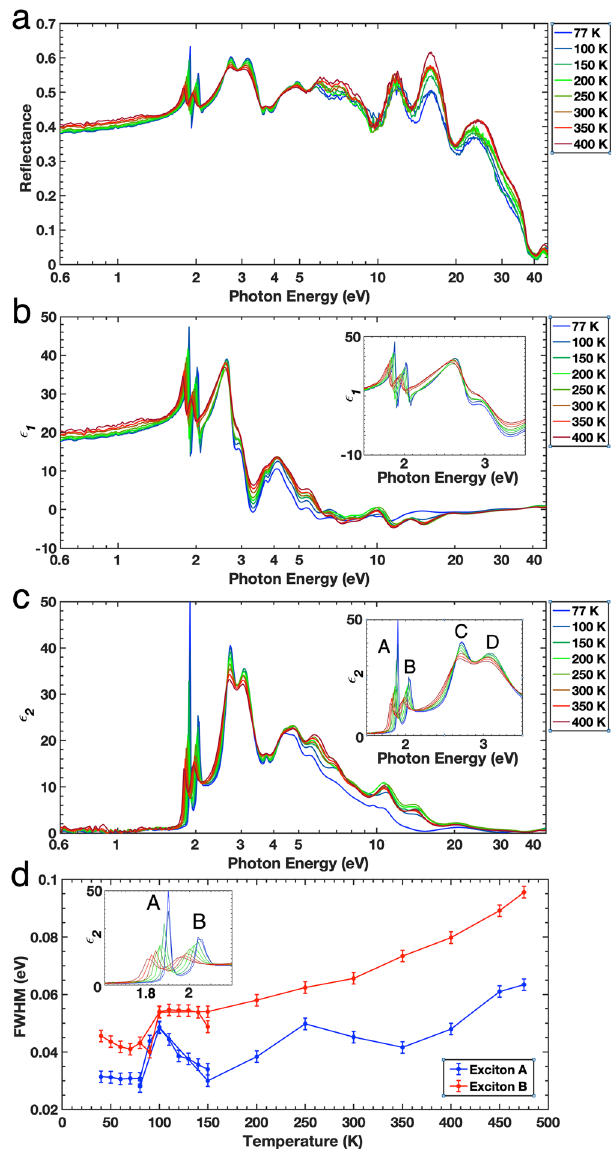
Fig. 1 Re fl ectance measurements and complex dielectric function of MoS 2 as a function of temperature. a Measurements of the re fl ectance of the bulk MoS 2 from the near-infrared (0.6 eV) up to soft X-ray (45 eV) using the SUV beamline at SSLS, log scale. The b real ( ε 1 ) part and c imaginary ( ε 2 ) part of the complex dielectric function of MoS 2 from spectroscopic ellipsometry and soft X-ray re fl ectance, log scale. d The FWHM of excitons A and B as a function of temperature showing signi fi cant change. Error bars are calculated using a 2 meV shift. Insets: Magni fi ed view of complex dielectric function of low-energy excitons from b and c on a linear